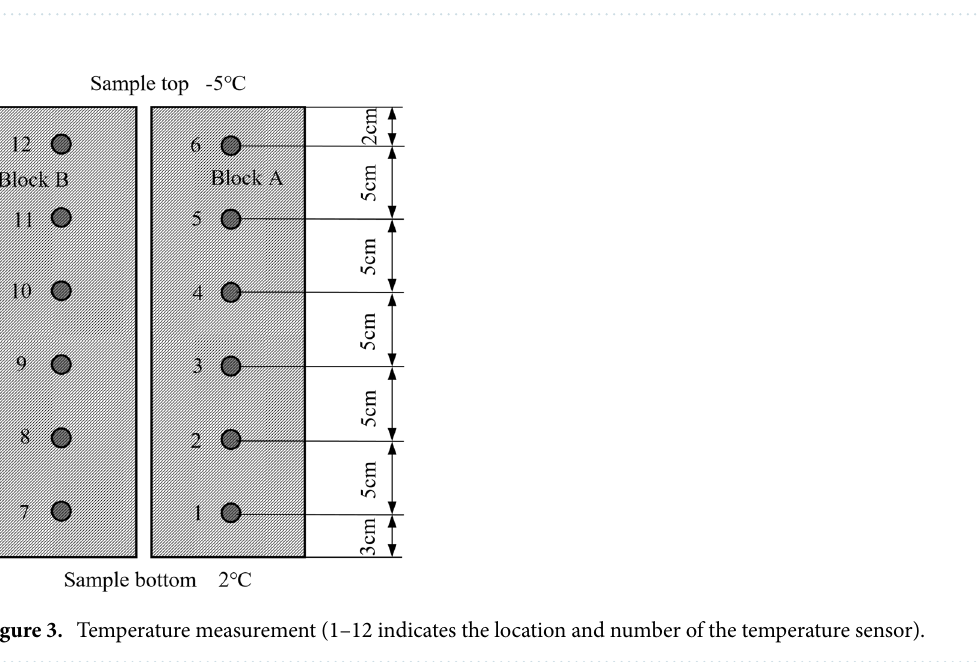
Figure 2. Schematic diagram of water supply and moisture migration measurement.